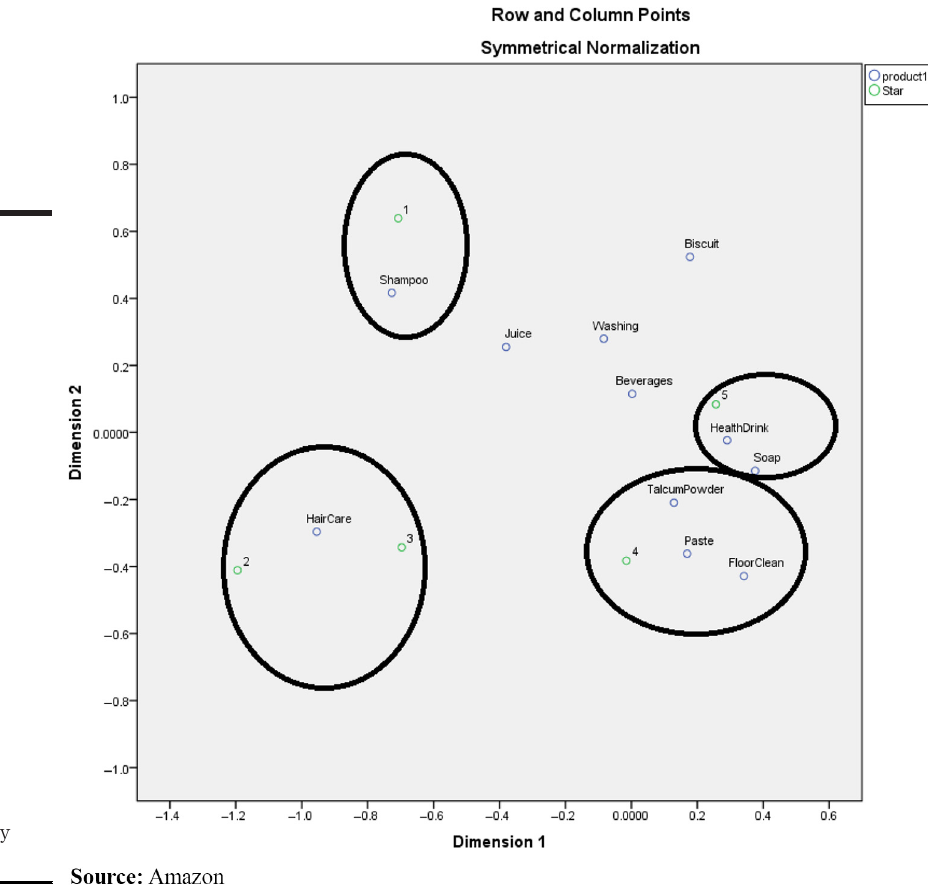
Figure 1. Star rating and product category